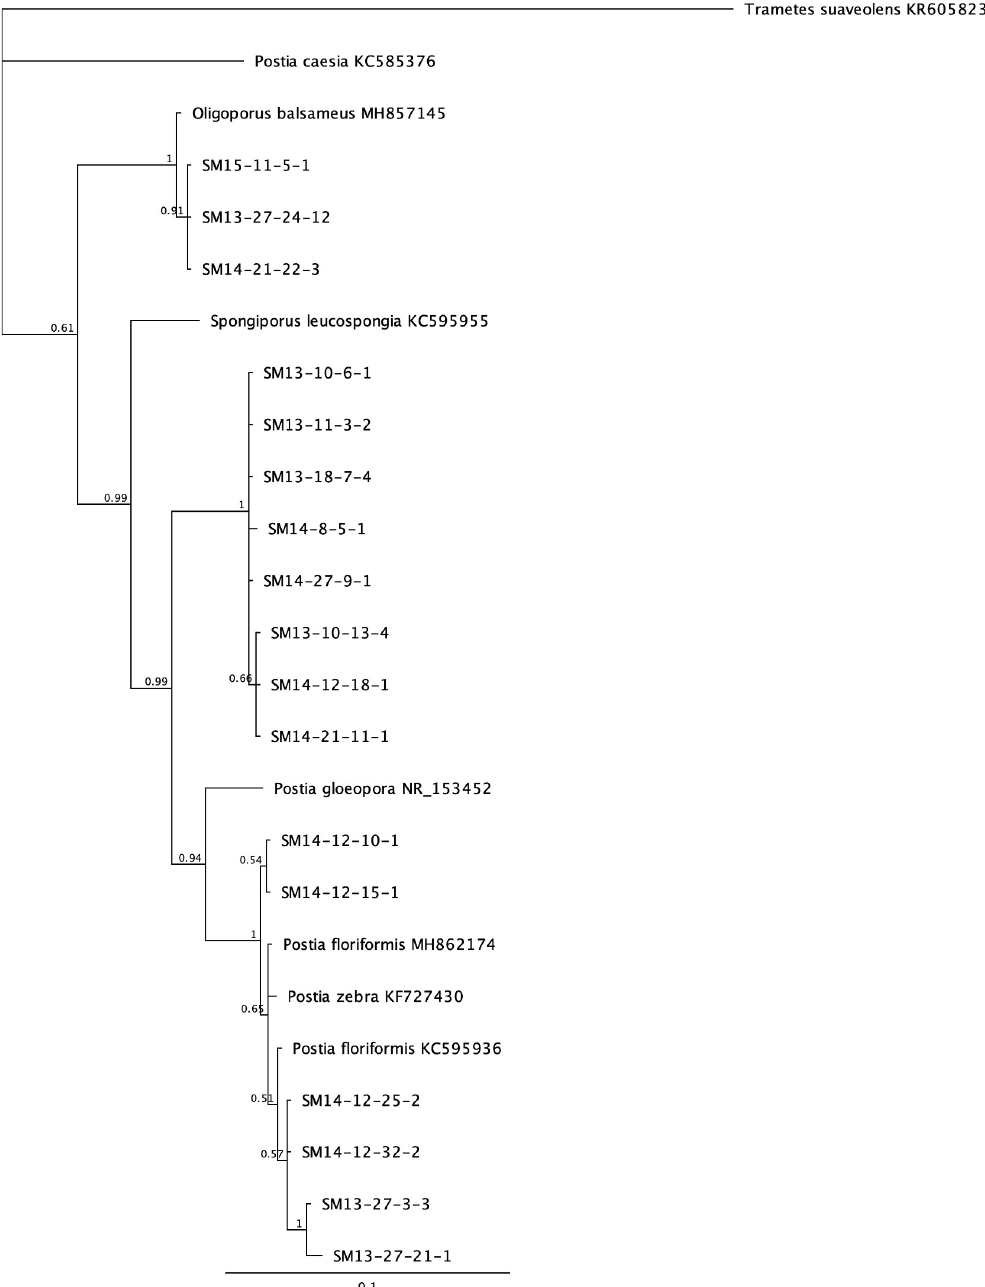
Fig 3. Bayesian tree constructed using ITS sequences from Postia species isolated from the Soudan mine (preceded with “SM”) and related genera. Posterior probabilities are shown at branches.